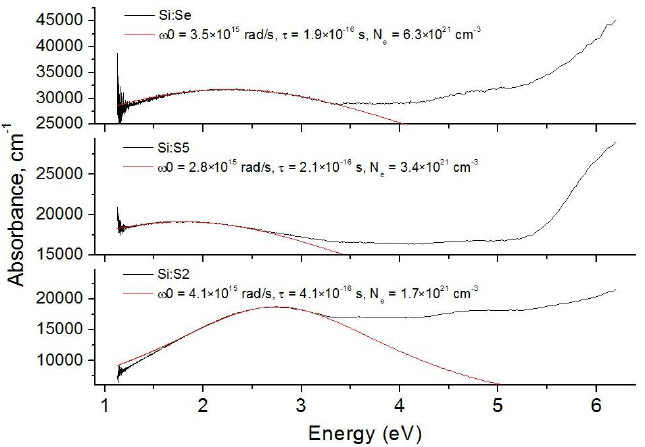
Figure 7. Approximation of absorption spectra and parameters of Drude ’s absorption function.